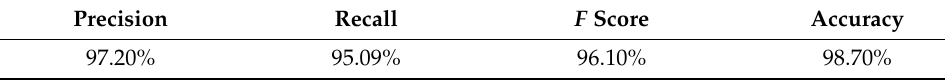
Table 1. Performance evaluation of TSDCNN on VRV